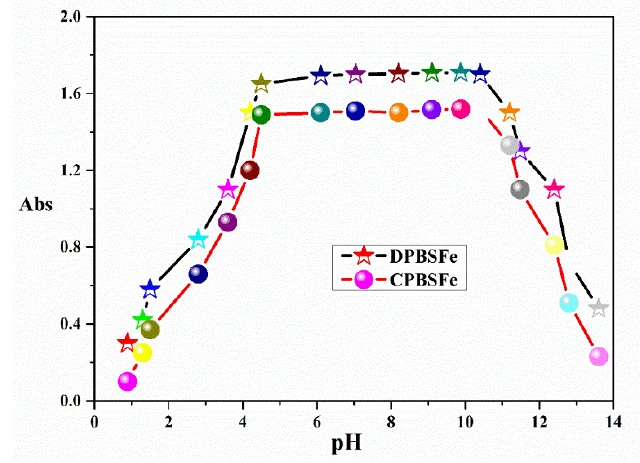
Figure 3. Stability of the prepared PDBSFe and CPBSFe chelates at different pH media.